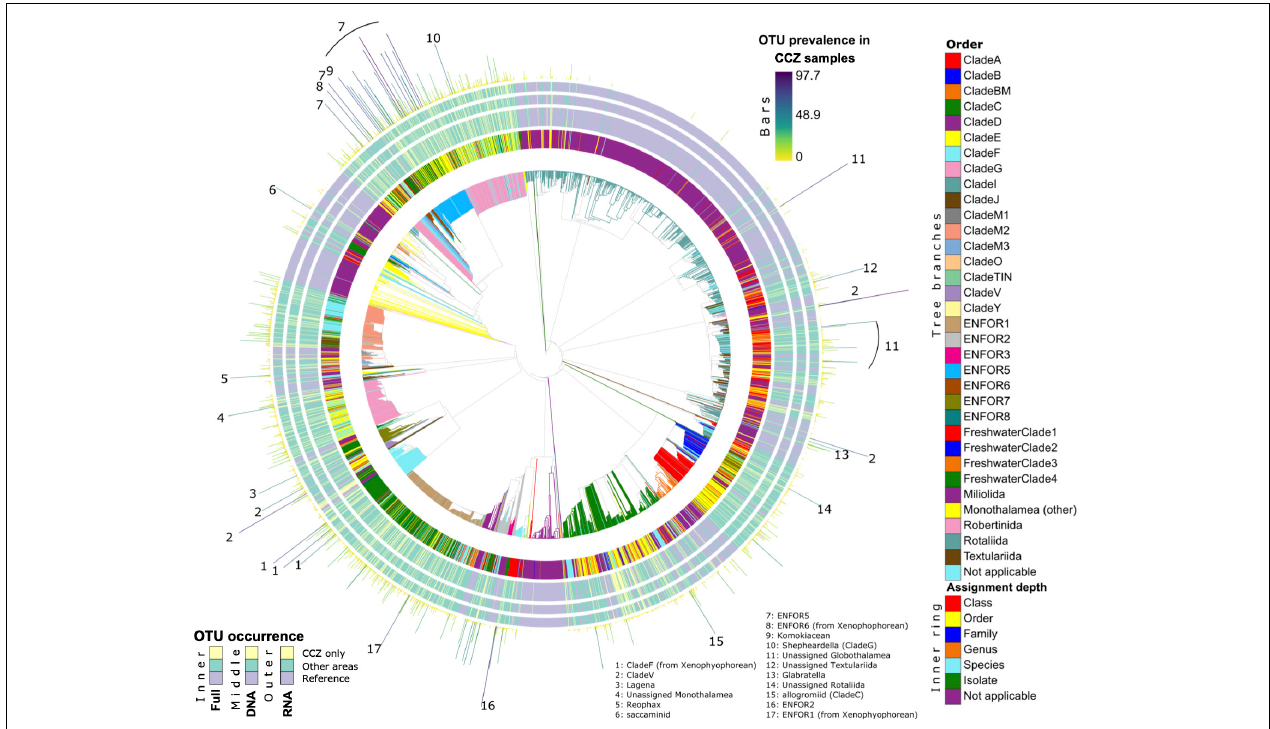
FIGURE 4 | Phylogenetic diversity and novelty of Foraminifera OTUs. The Foraminifera phylogeny is shown, expanded with 37F OTUs placements from this study. All legends similar to Figure 3 .